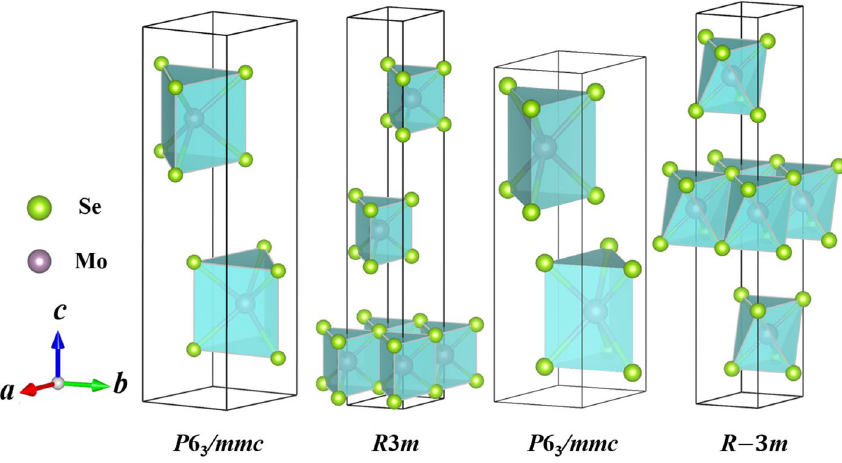
Figure 2. The crystal structures of MoSe 2 under high pressure up to 500 GPa. ( a ) P 6 3 /mmc , ( b ) R 3 m , ( c ) P 6 3 / mmc , and ( d ) R -3 m phases.